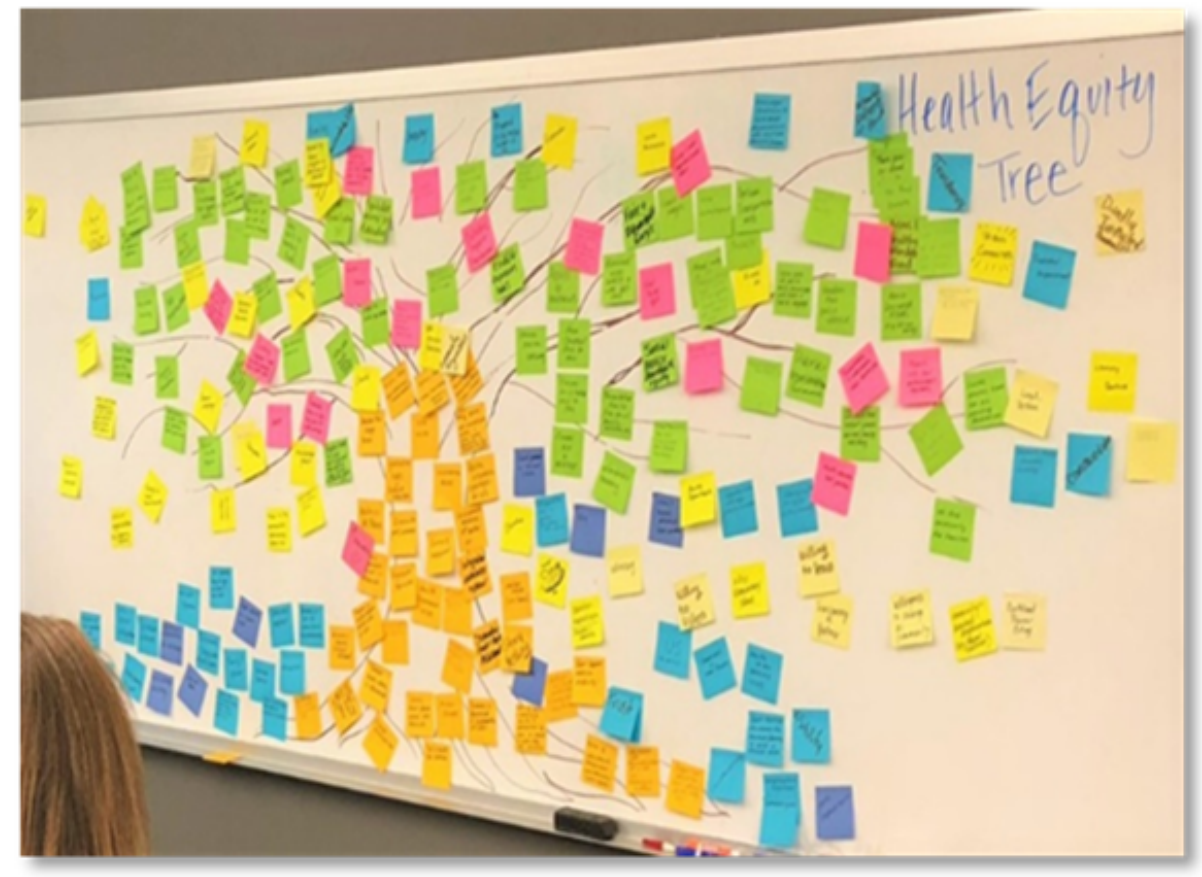
Figure 2. Community advisory council free-listing